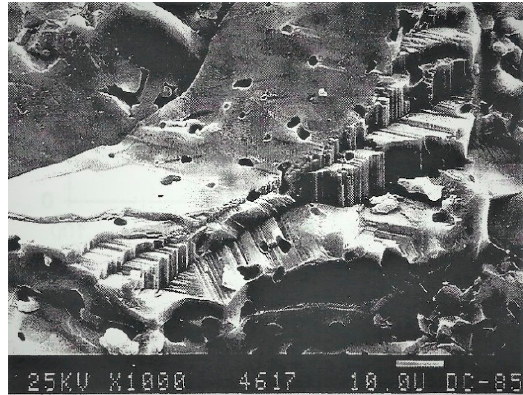
Figure 10. Fractured surface of Mg-PSZ.